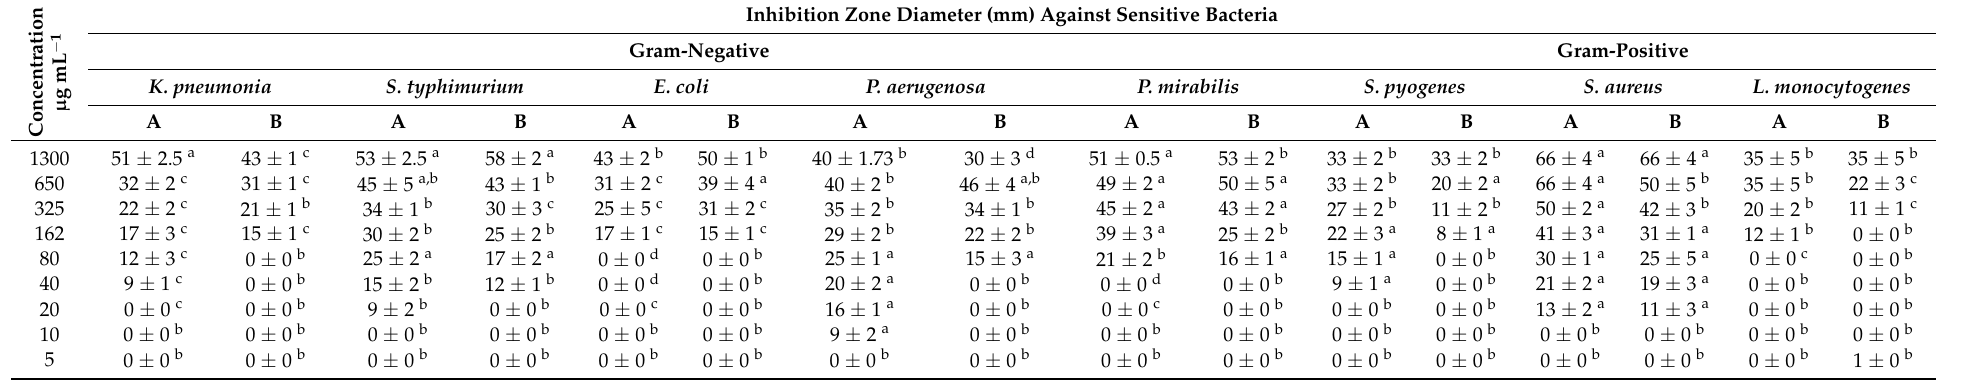
Table 3. Antibacterial activities of both Ag-FNP and Ag-MNP against different indicator bacterial